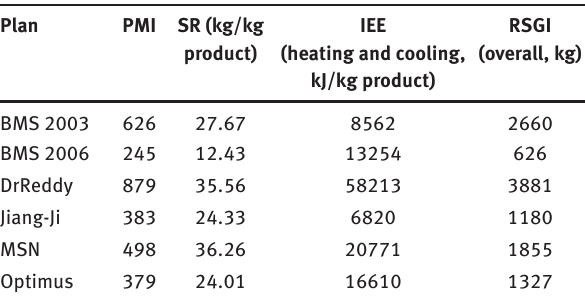
Table 2: Summary of essential metrics for 6 industrial plans to